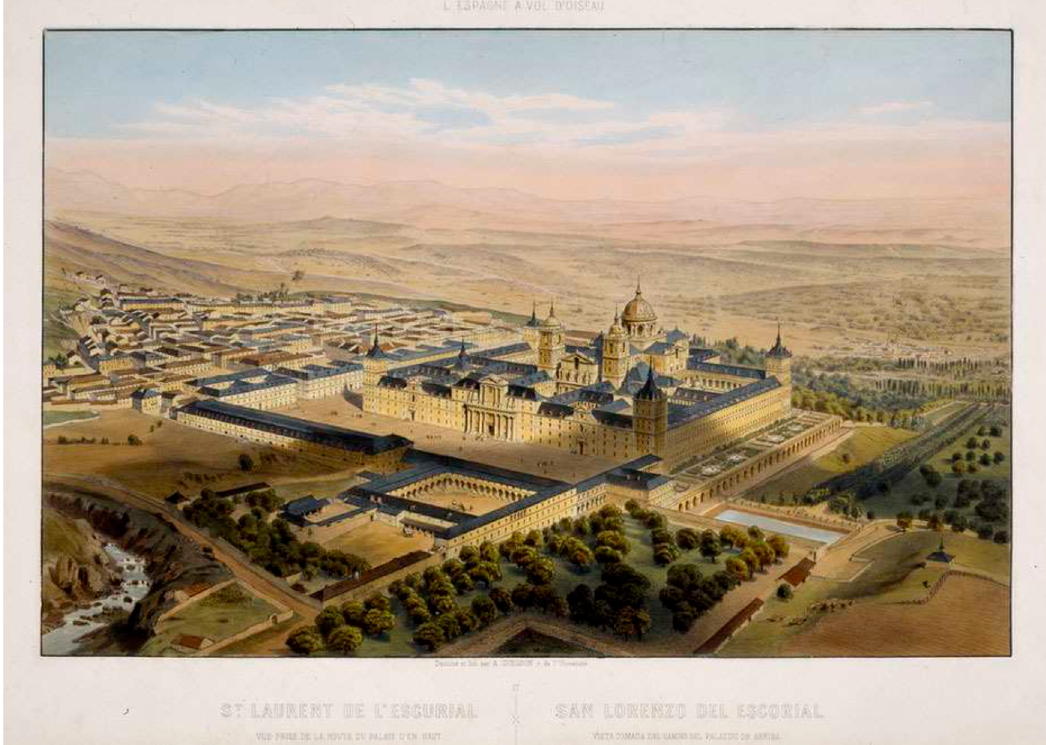
Figure 1. Alfred Guesdon, ca. 1855: L’Espagne à vol d’oiseau. San Lorenzo del Escorial. Vista tomada del camino del Palazzio de arriba . Aerial view of the Monastery from the west. The small square building in front of the main Monastery is the Botica, which is placed next to the Estanque grande (Big Pond) and the Jardín de los Frailes (Garden of the Friars), also is above the long Muro de los Nichos (Wall of the Niches). Biblioteca Nacional de España, Madrid, Bookmark Invent/069192.